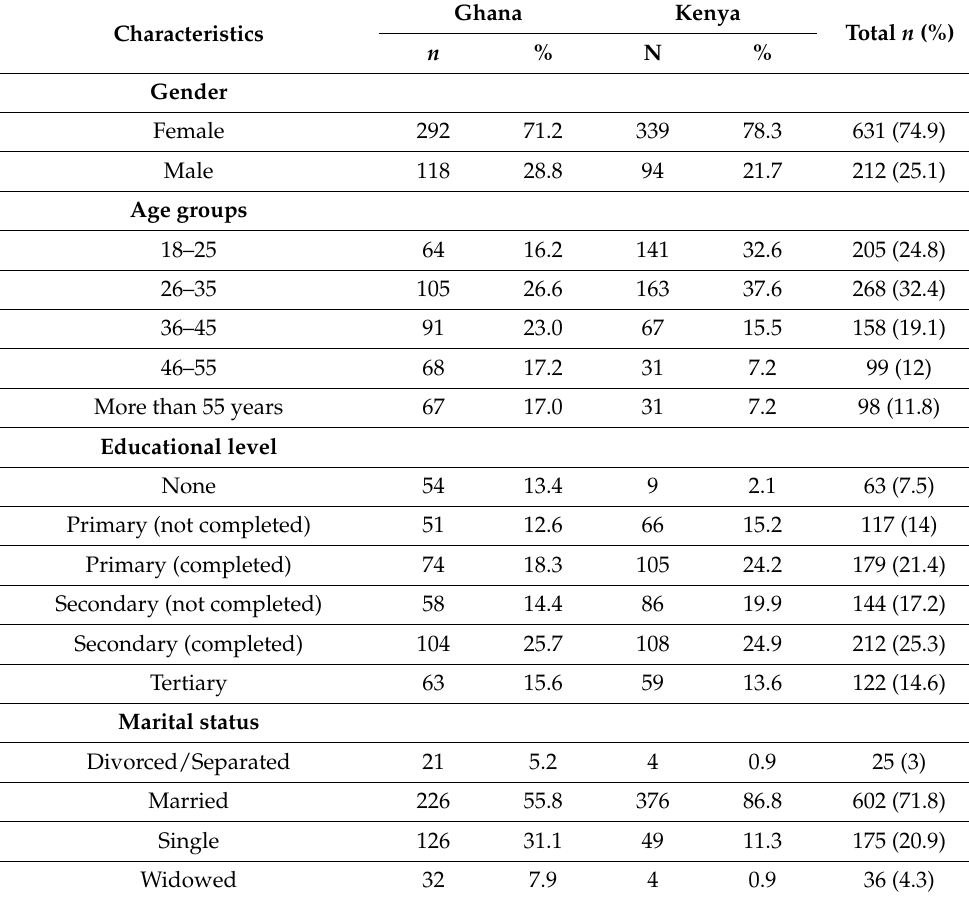
Table 2. Socio-demographic characteristics of study